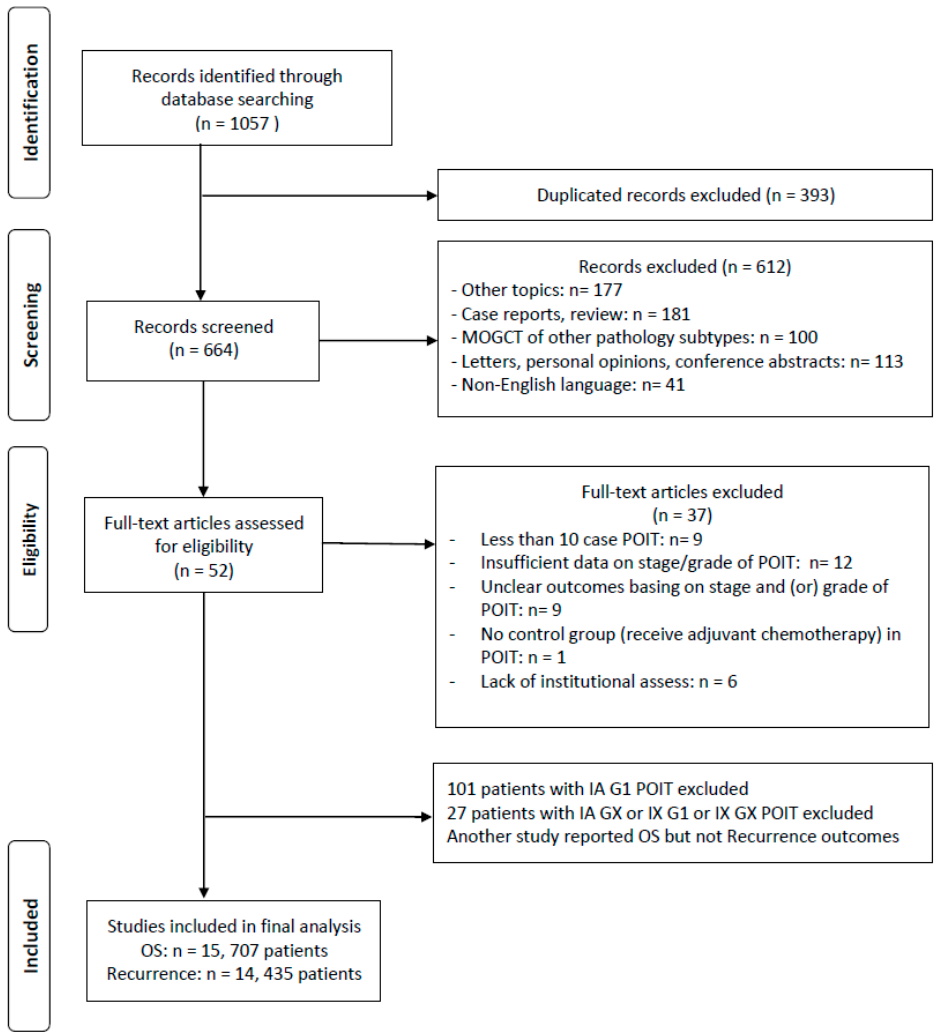
Figure 1. The PRISMA flow diagram showing the inclusions detailed in this study.